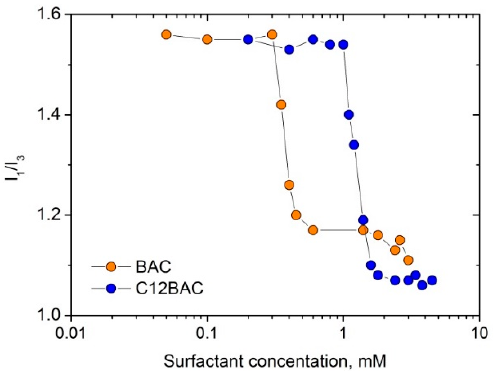
Figure 7. Polarity parameter of pyrene I 1 /I 3 as a function of the concentration of cationic surfactants: benzalkonium chloride BAC and benzyldimethyldodecylammonium chloride C12BAC. benzalkonium chloride BAC and benzyldimethyldodecylammonium chloride